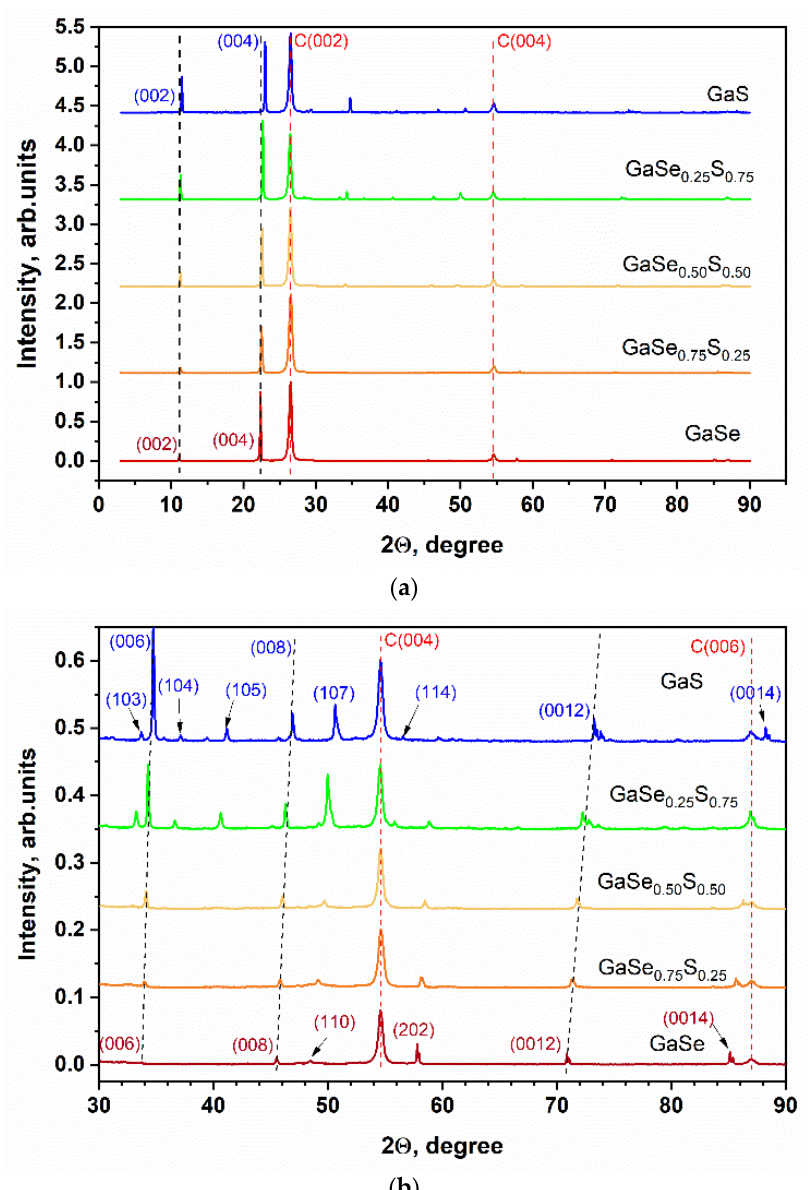
Figure 8. Full range ( a ) and 30 – 90 degrees range ( b ) XRD patterns of the LPE GaSe 1 − x S x films. Figure 9 shows the result of the determination of the energy band gap of GaSe 1 − x S x films by the Kubelka-Munk (K-M) method from diffuse reflection spectra. The linear interpolation of the plots of (F(R) × h ν ) 2 vs. h ν for the quadratic approximation shows that direct transition photon energy is ~1.97 eV for GaSe and ~2.79 eV for GaS LPE films. For the films of ternary GaSeS compounds, this value is equal to ~2.14, ~2.32, and ~2.56 eV for GaSe 0.75 S 0.25 , GaSe 0.50 S 0.50, and GaSe 0.25 S 0.75 , respectively. The defined values of the energy of direct transition are consistent with the data in the literature for the corresponding GaSe 1 − x S x crystals, as reported in [27]. The energy of the indirect transition has lower values. The determined photon energy is ~1.92 eV for GaSe films and ~2.52 eV for GaS films. Analogous to the trends in direct transition energy, the value of the energy of indirect transitions for the GaSeS ternary films increases with the increasing sulfur content and equals ~2.04, ~2.12, and ~2.28 eV for the GaSe 0.75 S 0.25 , GaSe 0.50 S 0.50, and GaSe 0.25 S 0.75 compounds,